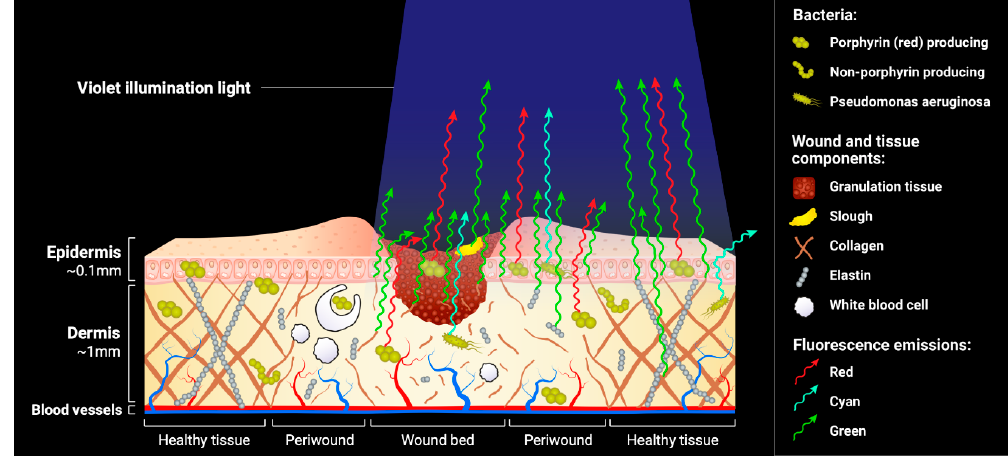
Figure 2. Fluorescence emissions from tissues and bacteria. When illuminated by the 405 nm violet light, extracellular matrix components emit green fluorescence, porphyrin-producing bacteria emit red fluorescence, and Pseudomonas aeruginosa emits cyan fluorescence. Subsurface fluorescence can be detected; however, the fluorescence emissions are blunted by optical scattering as a result of passing through overlying tissues. This is depicted by shorter fluorescence emission arrows coming from subsurface tissues and subsurface bacteria. Note that components deeper in the dermal later (>1.5 mm) will not emit detectable fluorescence signals because the violet excitation light cannot penetrate the tissue far enough to reach them.